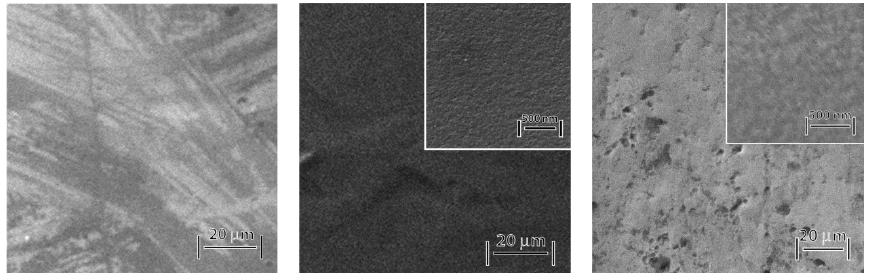
Figure 2. SEM images of the (111) face of the diamond: ( a ) before irradiation, ( b ) after irradiation with 30 keV Ar + 230 ◦ C ions and ( c ) after irradiation with 30 keV C + 650 ◦ C